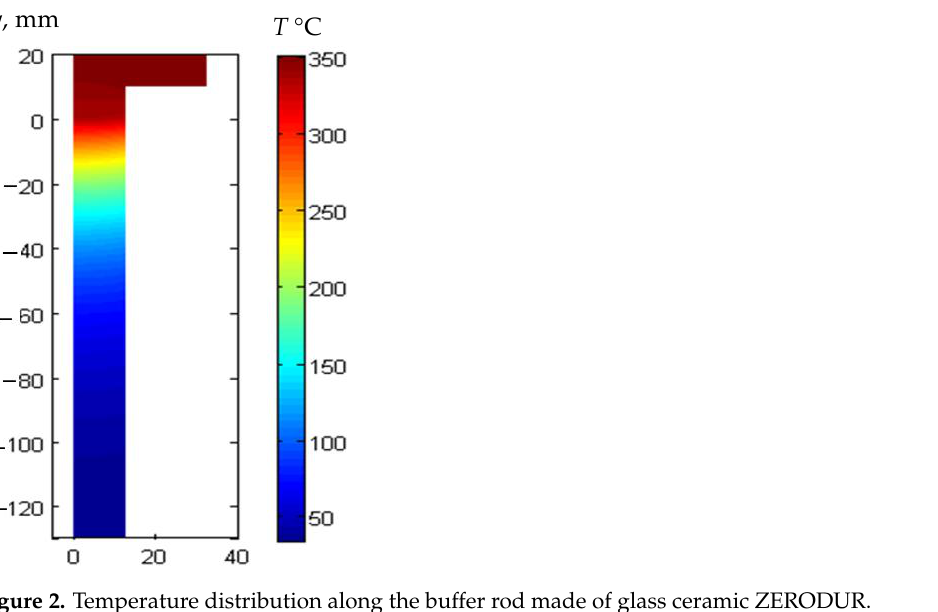
Figure 2. Temperature distribution along the buffer rod made of glass ceramic ZERODUR.